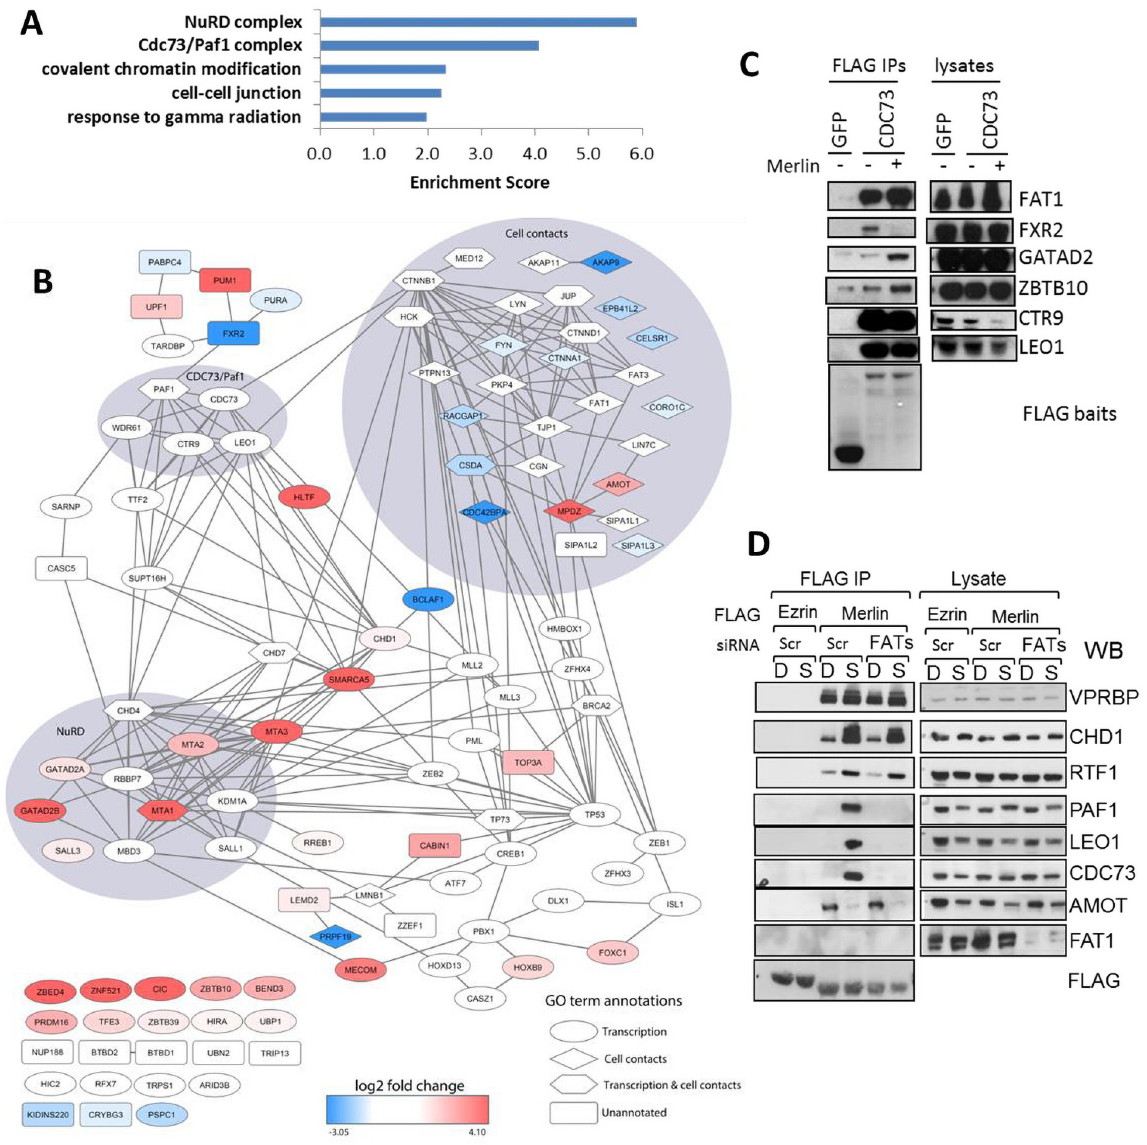
Fig 7. FAT cadherins interact with CDC73 and are necessary for Merlin interaction with PAFC. (A) Gene Ontology term enrichment of the CDC73 interactome in 293T cells. TAP6-CDC73 was affinity purified from 293T cells co-expressing either Merlin or Ezrin. Co-purifying proteins were subjected to functional annotation analysis with GO biological process, cellular component and molecular function terms using DAVID [38]. Top 5 results shown. Terms correspond to GO:0010332, GO:0005911, GO:0016569, GO:0016593 and GO:0016581. (B) Bioinformatics analysis of the CDC73 interactome and its regulation by Merlin. Proteins from the STRING functional network were annotated with log2 fold change regulation in Merlin- vs Ezrin-expressing cells (red, upregulated; blue, downregulated in cells over-expressing Merlin; white, unchanged). The shape of protein nodes represents the functional annotations (ellipse: transcription; diamond: cell contacts; hexagon: annotated with both transcription and cell contacts; rectangle: not annotated with these terms). Proteins highlighted with a background surface were annotated with functional terms and cluster together in the network. See also S12 Table and supplementary methods. (C) Validation of some interactions identified by CDC73 AP-MS. Flag-CDC73 or Flag-GFP were expressed in 293T cells with either empty vector or Merlin and Flag-IPs probed with the indicated antibodies. (D) FAT cadherins are required for Merlin interaction with PAFC. 293T cells were transfected with scramble or siRNAs against FAT1, FAT3 and FAT4 and 24 hours later transfected with either Flag-Ezrin or Merlin. Flag immunoprecipitates from dense or sparse cells were probed as